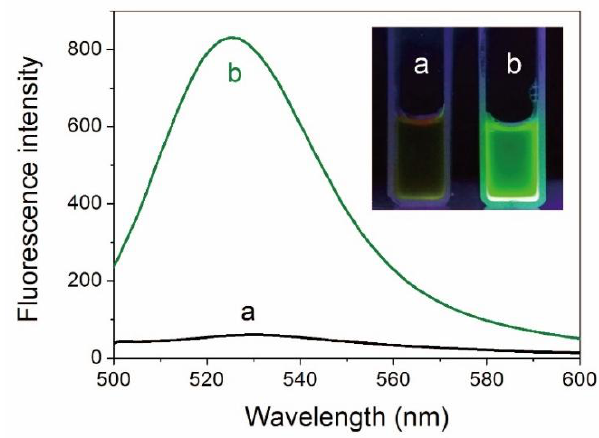
Figure 1. Fluorescence spectra of 6-aza-2-thio-thymine protected gold nanoclusters (ATT-AuNCs) ( a ) before and ( b ) after introducing bovine serum albumin (BSA). The concentrations of ATT-AuNCs and BSA were 0.5 mg/mL and 500 μg/mL, respectively. Inset: Photographs of ATT-AuNC and BSA/ATT-AuNC solutions under UV light.